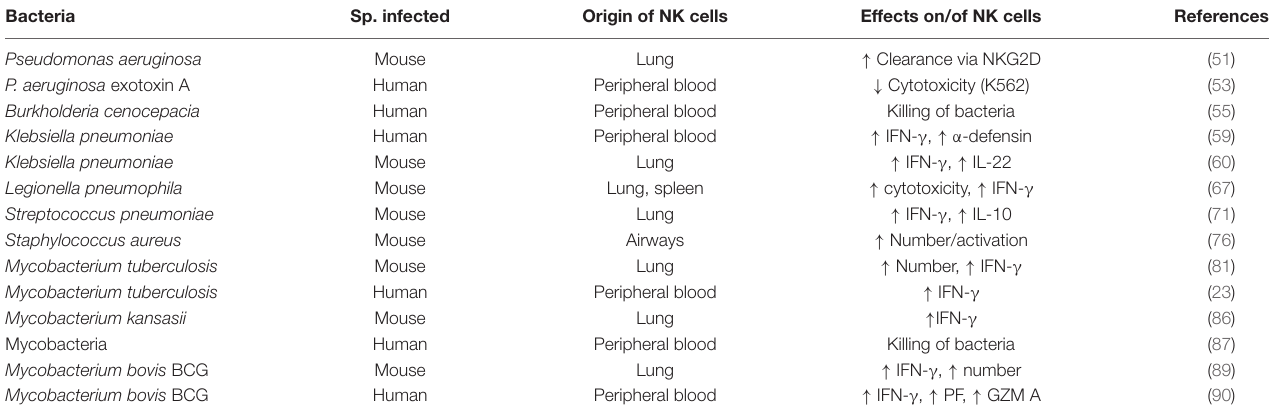
TABLE 2 | Natural Killer (NK) cells and different